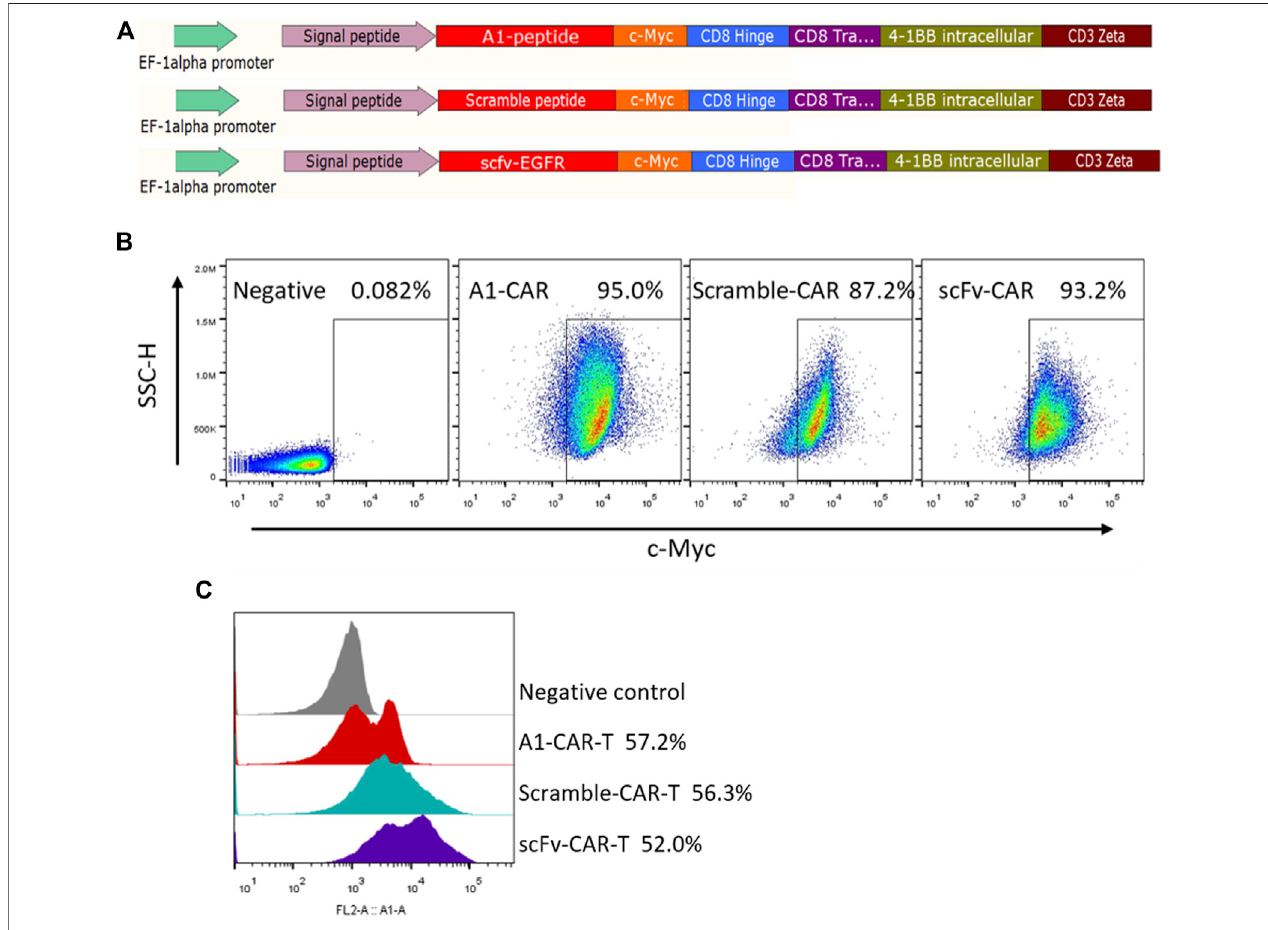
FIGURE 1 | Design and characteristics of peptide-based CARs. (A) Lentiviral constructs of peptide-based A1-CAR, Scramble-CAR and EGFR-scFv-CAR. (B) Surface expression of the CAR on Jurkat cells at the end of the primary expansion on day 3 detected by binding to c-Myc antibody. Representative of three donors. (C) SurfaceexpressionoftheCARonthehumanTcellsattheendoftheprimaryexpansiononday3detectedbybindingtoc-Mycantibody.Representativeofthreedonors.